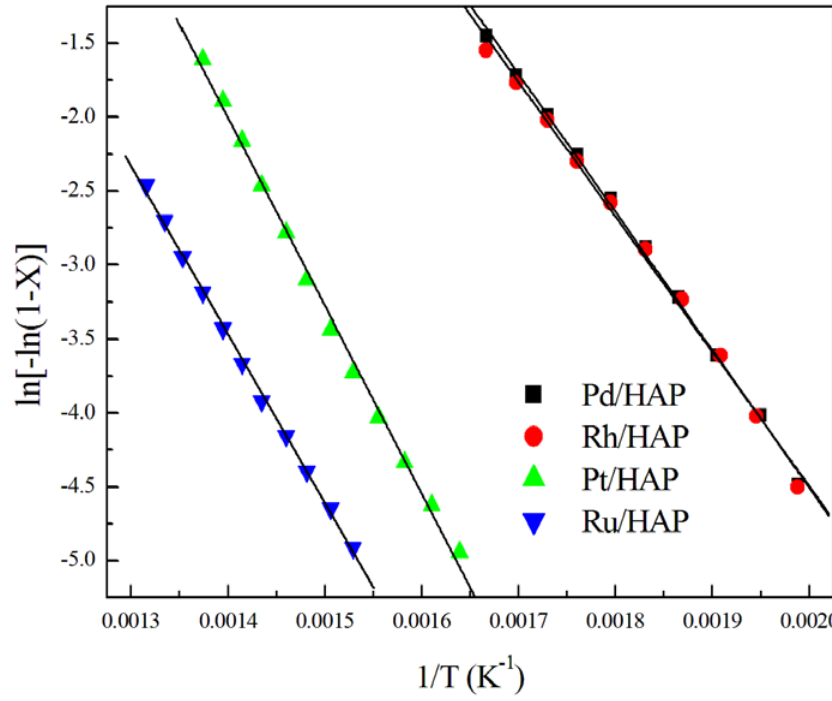
Figure 7. Arrhenius plots for methane oxidation over the noble metal catalysts.